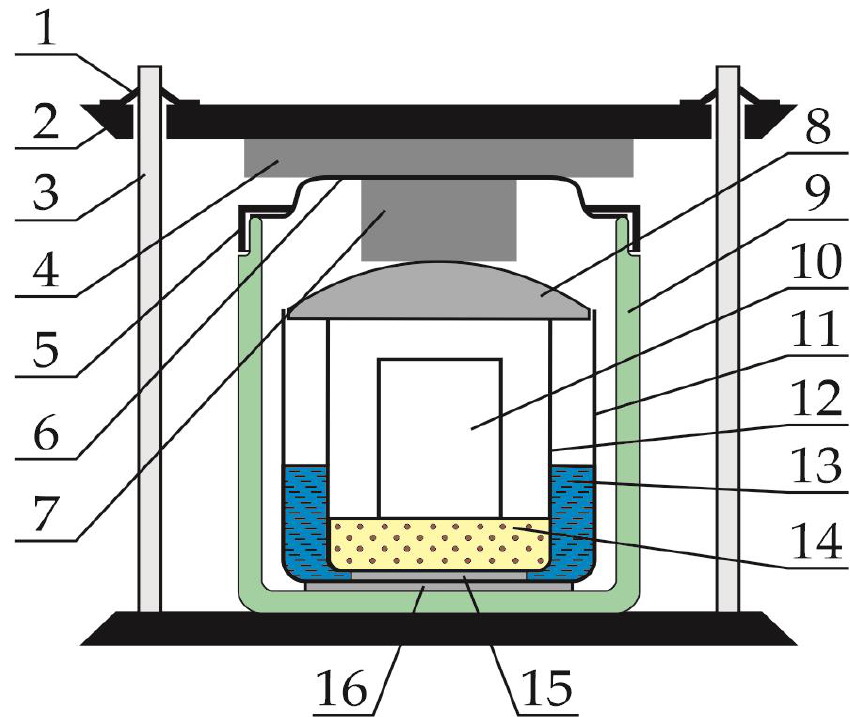
Figure 3. Scheme of the measuring block. Number 1 — cardboard marker; 2 — steel plate; 3 — guide